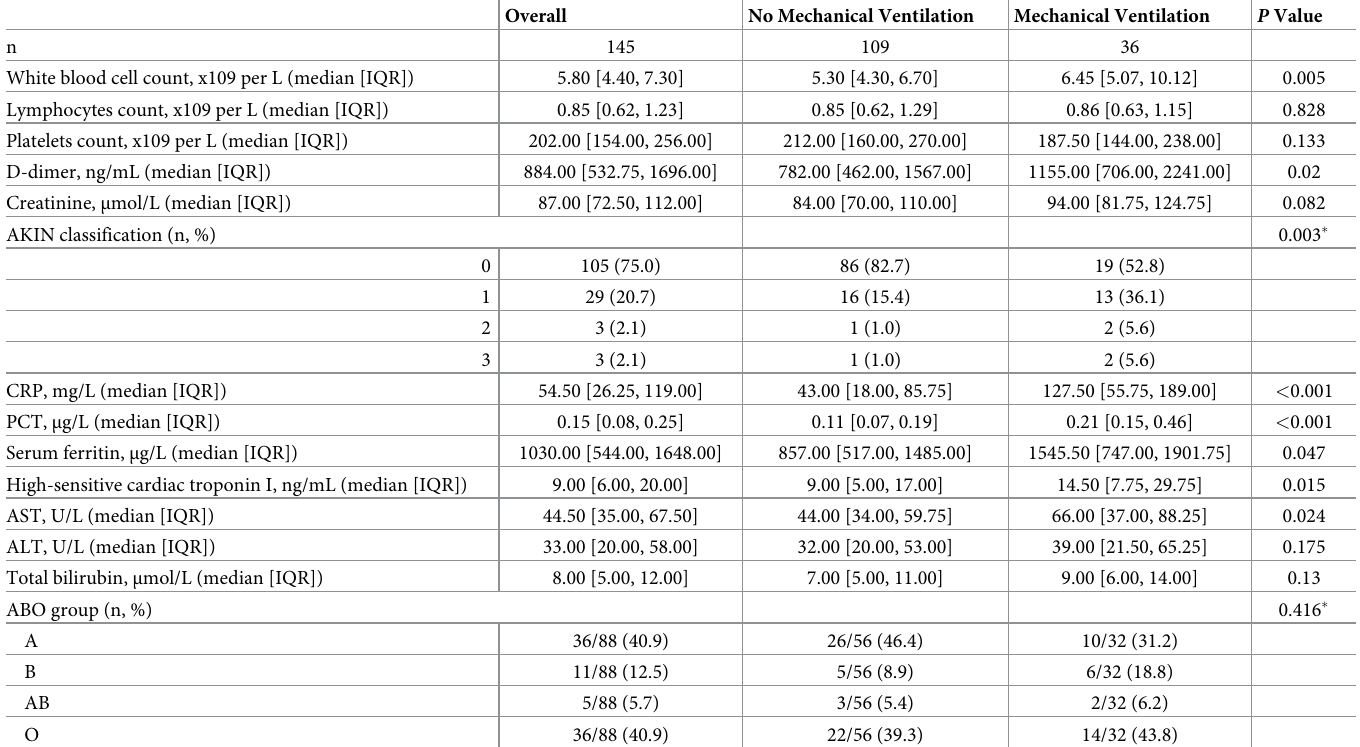
Table 4. Laboratory values of patients on admission.